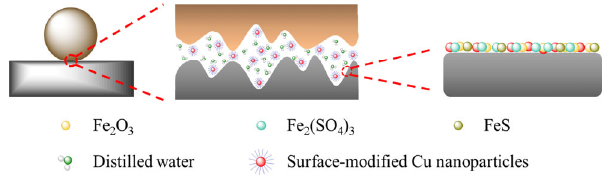
Fig. 11 The lubrication model of as-synthesized water-soluble Cu nanoparticles as additive in distilled